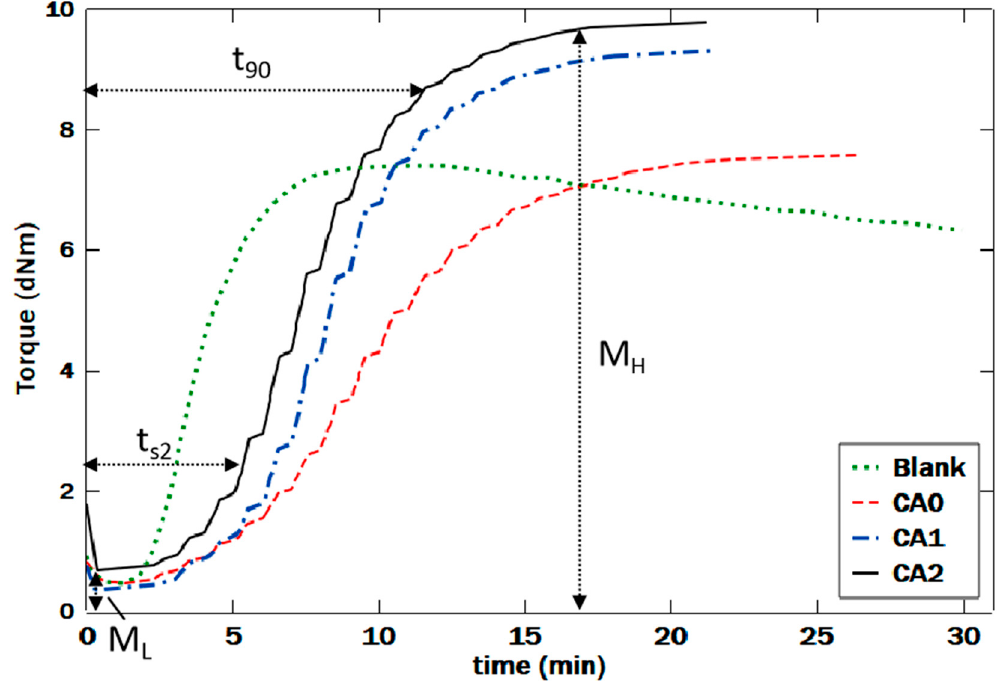
Figure 7. Rheological profile of the natural rubber composite compounds during measuring the rheometer in 150 °C. rheometer in 150 ◦